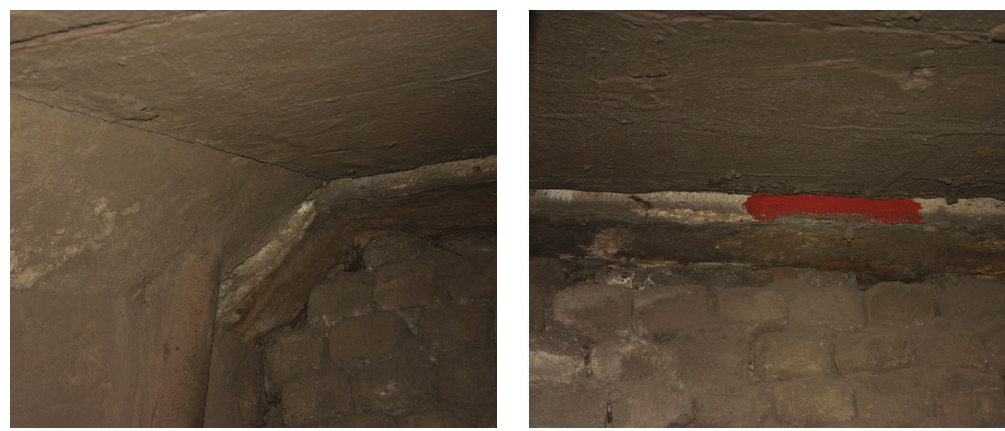
Fig. 2. Vertical displacement on the joint of the L-1 segment of the ventilation duct with shaft collar, from the shaft’s